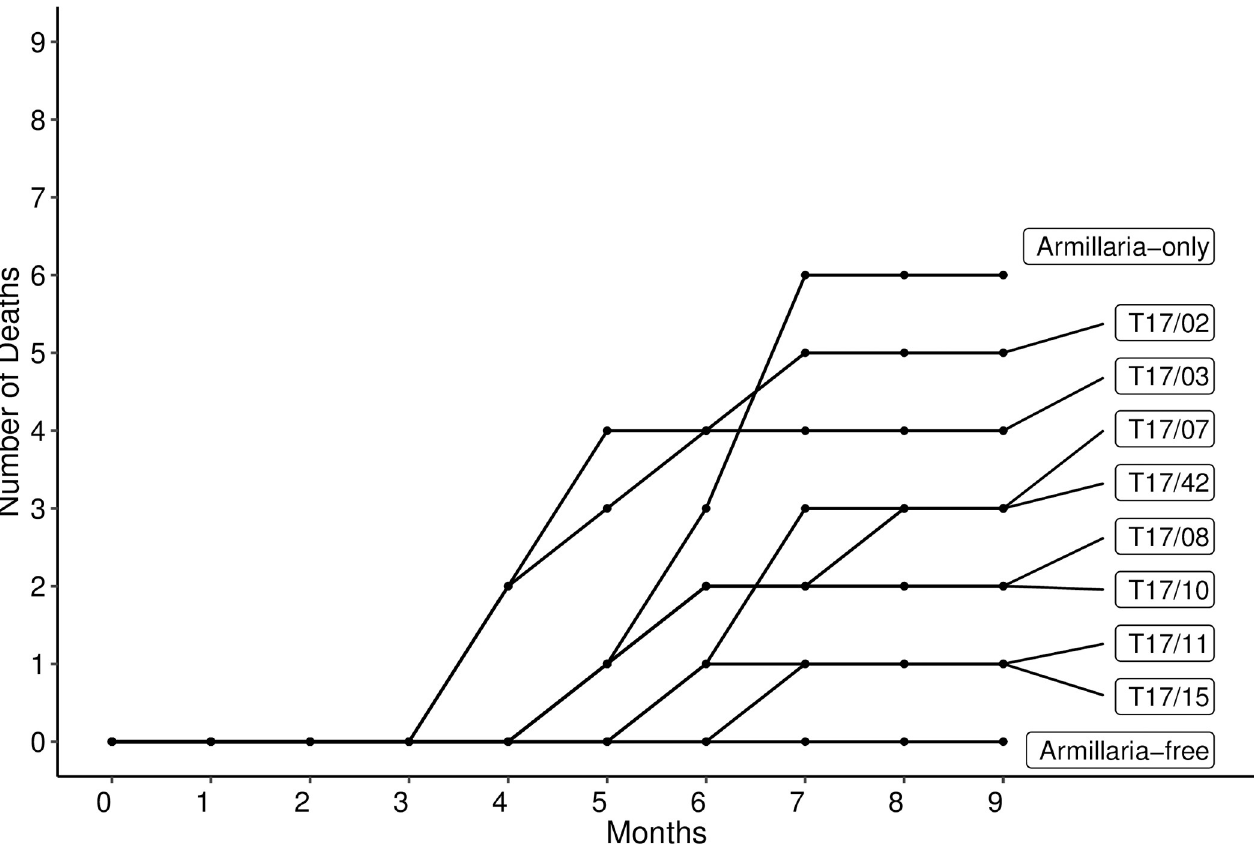
Fig 3. Number of privet plant deaths by Armillaria mellea CG440 over nine months. Treatments included two nil -Trichoderma controls (with and without Armillaria ) and eight Trichoderma isolates (n = 9). Trichoderma species included T . atrobrunneum (T17/11 and T17/15), T . hamatum (T17/10), T . harzianum (T17/03, T17/07, T17/08), T . olivascens (T17/42) and T . virens